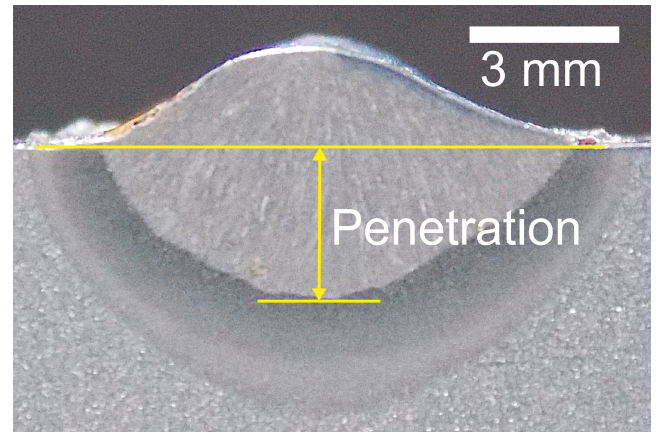
Figure 5. Test specimen optimized in relation to the penetration of the solder.